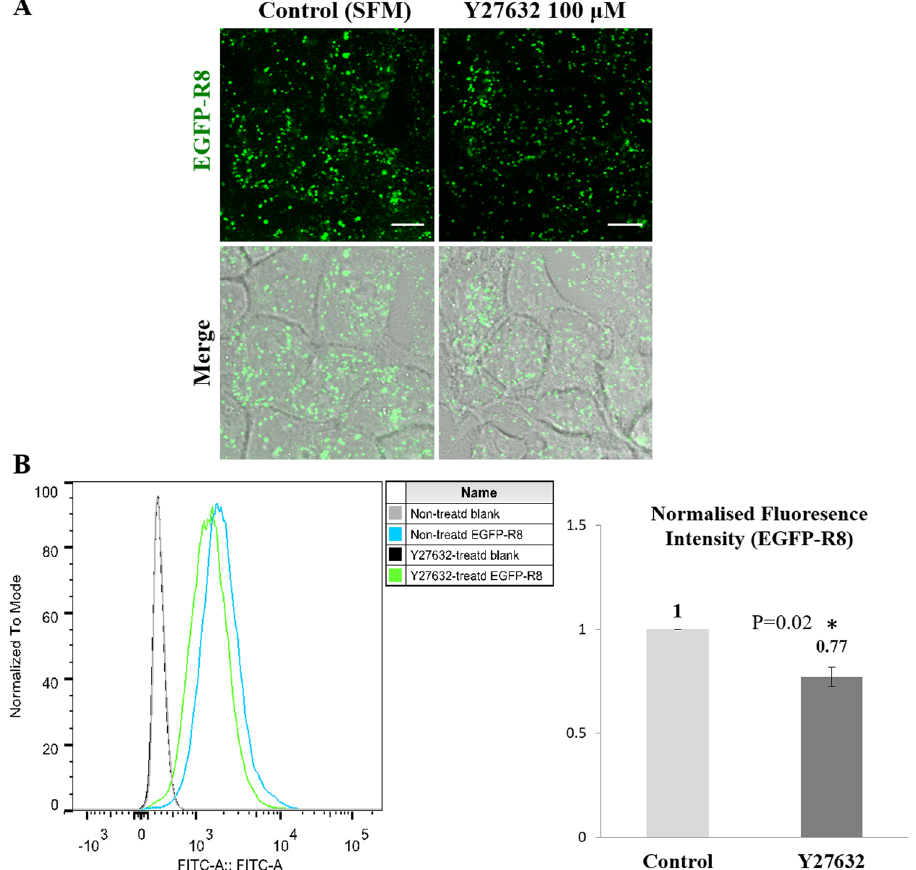
Figure 8. Effects of Y27632 on the cellular uptake of EGFP-R8 in A431 cells. Cells were preincubated with diluent control or 100 µ M Y27632 for 4 hr prior to incubation with 2 µ M EGFP-R8 for 1 hr in the absence (control) or presence of 100 µ M Y27632 and washed with heparin. ( A ) Cell associated fluorescence was analysed using confocal microscopy and shown are single projection images of fluorescence only and merge of fluorescence and DIC of the same cells. Scale bars 10 µ m. ( B ) Cells were washed, trypsinised and analysed by flow cytometry. Data represent the mean of geometric means ± S.D. from three independent